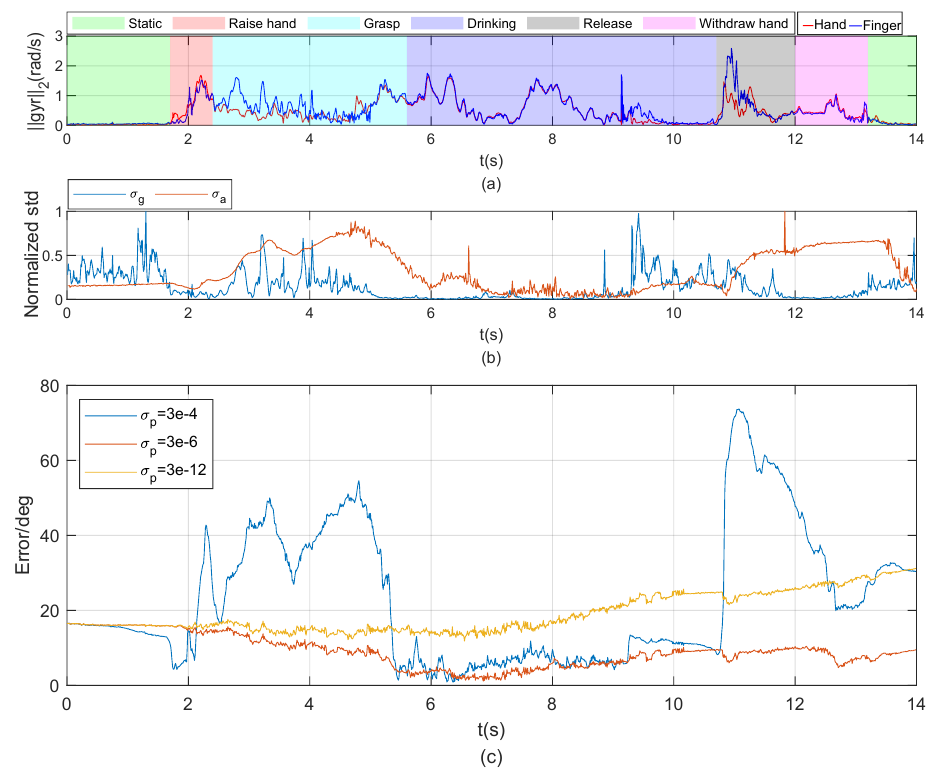
Figure 8. Relative orientation between hand and thumb during the water-drinking process. Subfigure ( a ) shows the output norms of the two gyroscopes (on the hand and finger tip respectively). Subfigure ( b ) shows the normalized SDs σ a and σ g from Equations (18) and (21). Larger σ a and σ g mean larger measurement error. The EKF trusts the process model more and the measurement model less when σ a and σ g are larger. Subfigure ( c ) shows the estimated results with different SDs of the process model. The variance of process error Q was determined as σ p I 4